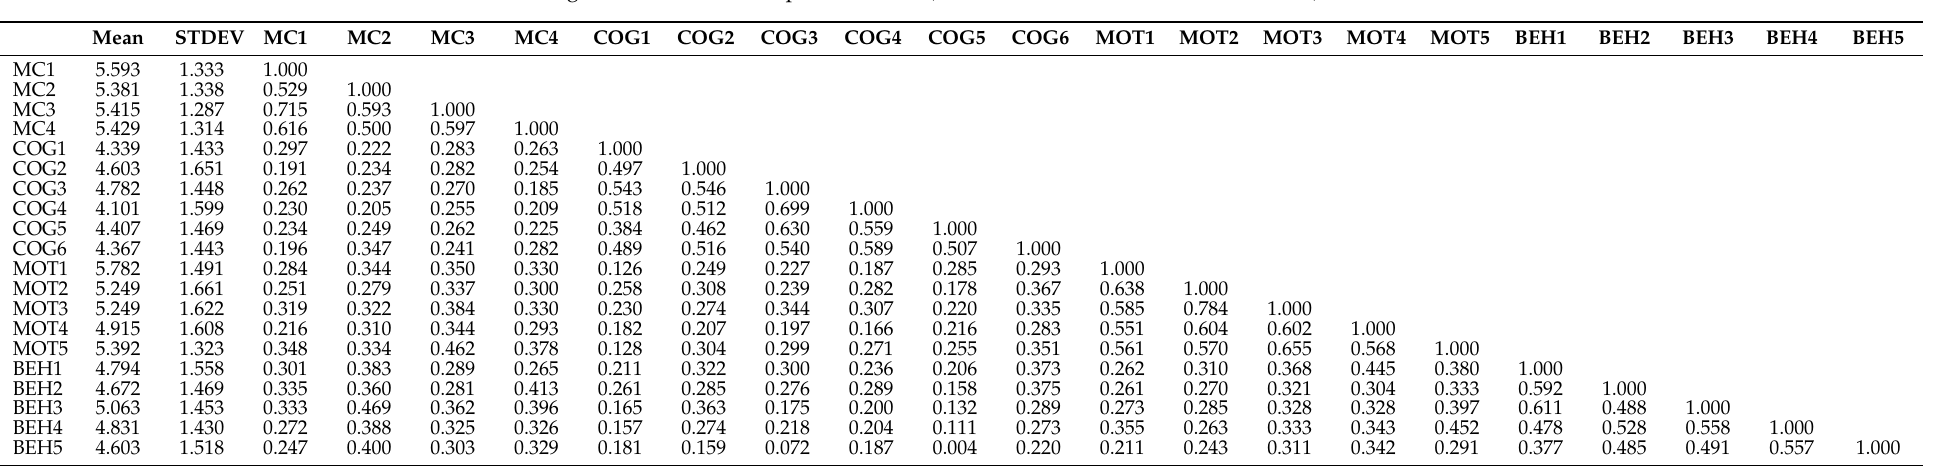
Table A1. Cultural intelligence indicators descriptive statistics (mean, standard deviations,